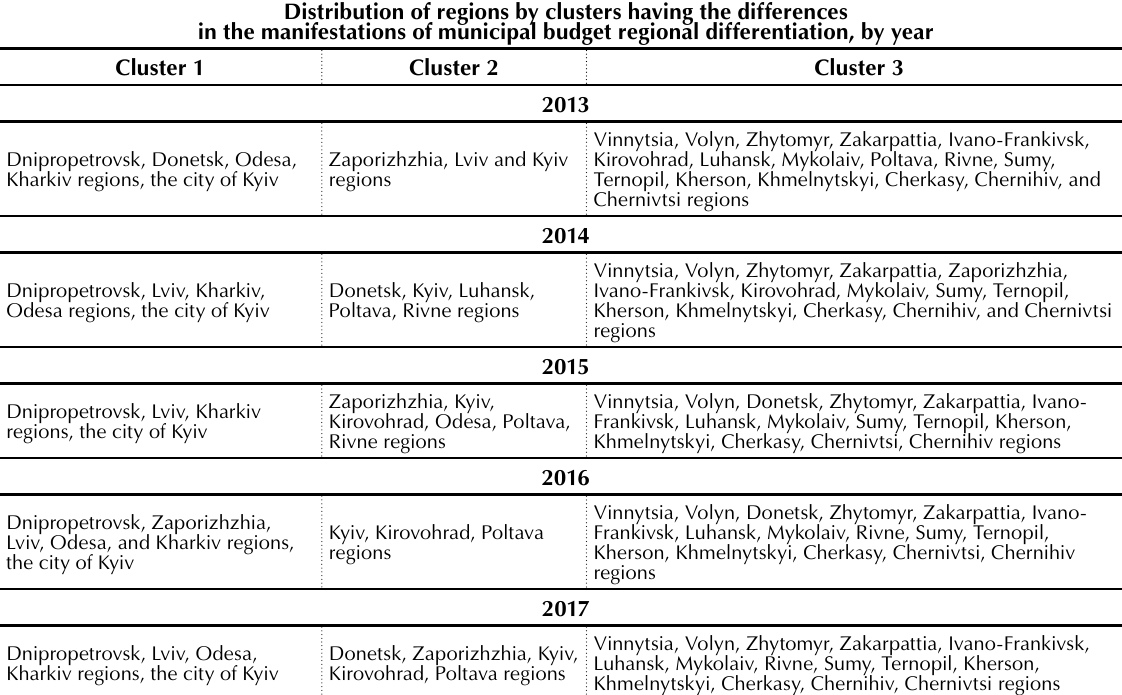
Table 2. Distribution of regions according to the regional differentiation of municipal budgets, 2013–2017 Distribution of regions by clusters having the differences in the manifestations of municipal budget regional differentiation, by